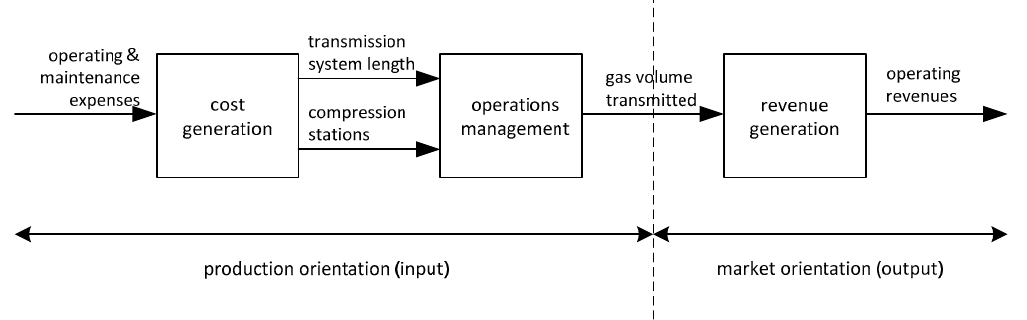
Figure 1. The multi ‐ stage production model of the gas infrastructure system. Figure 1. The multi-stage production model of the gas infrastructure